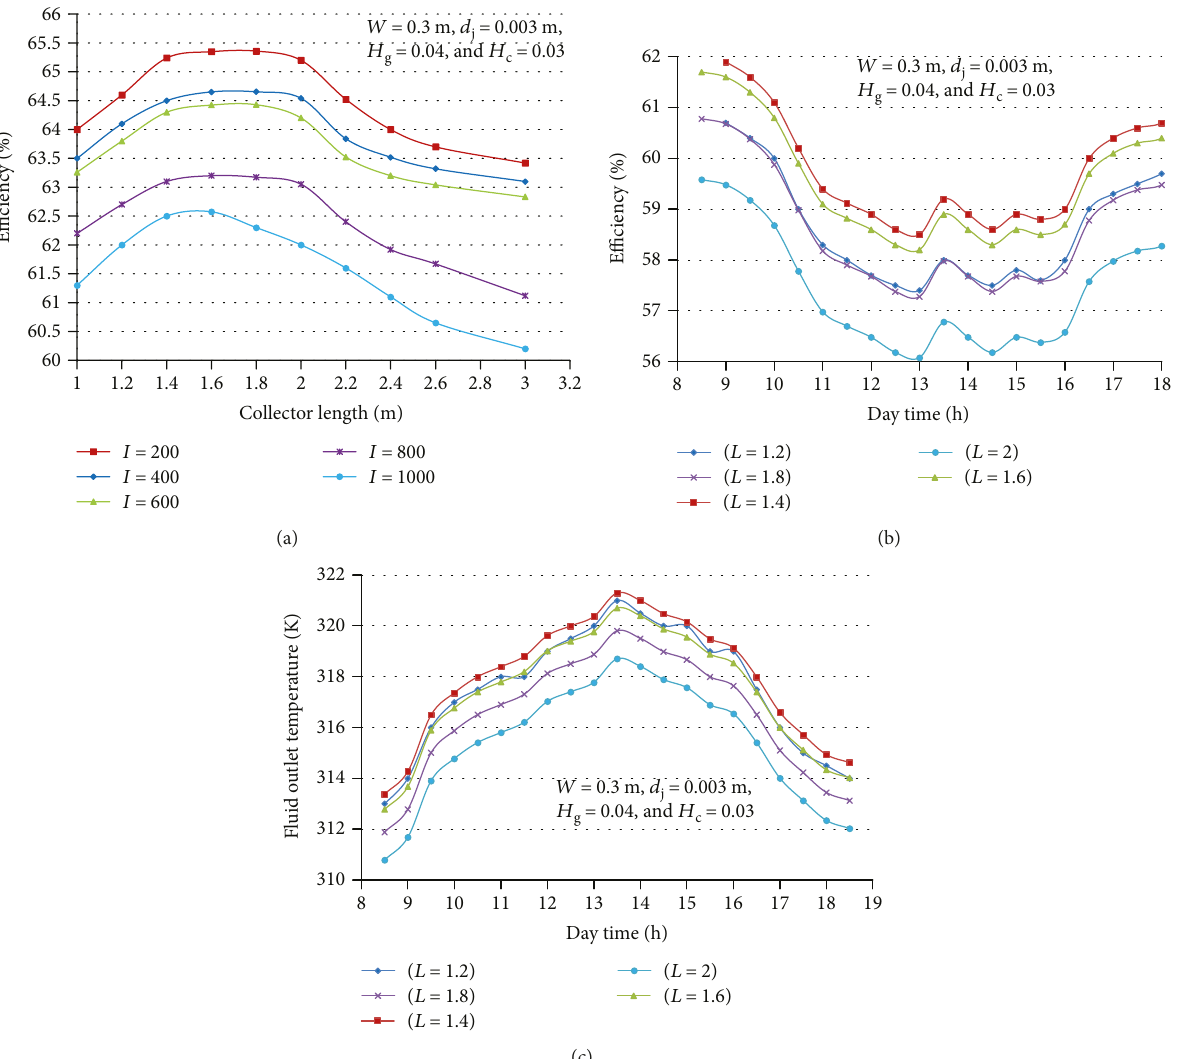
Figure 19: Prediction of the optimum length (L) of the proposed solar air heater. (a) SAH e ffi ciency versus collector length at di ff erent solar radiation levels. (b) Hourly SAH e ffi ciency over daytime at di ff erent collector lengths. (c) Hourly air outlet temperature at di ff erent collector